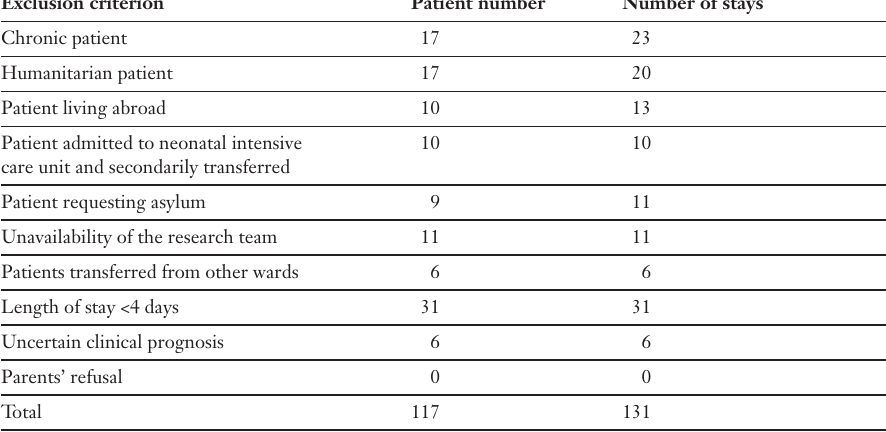
Distribution of exclusion